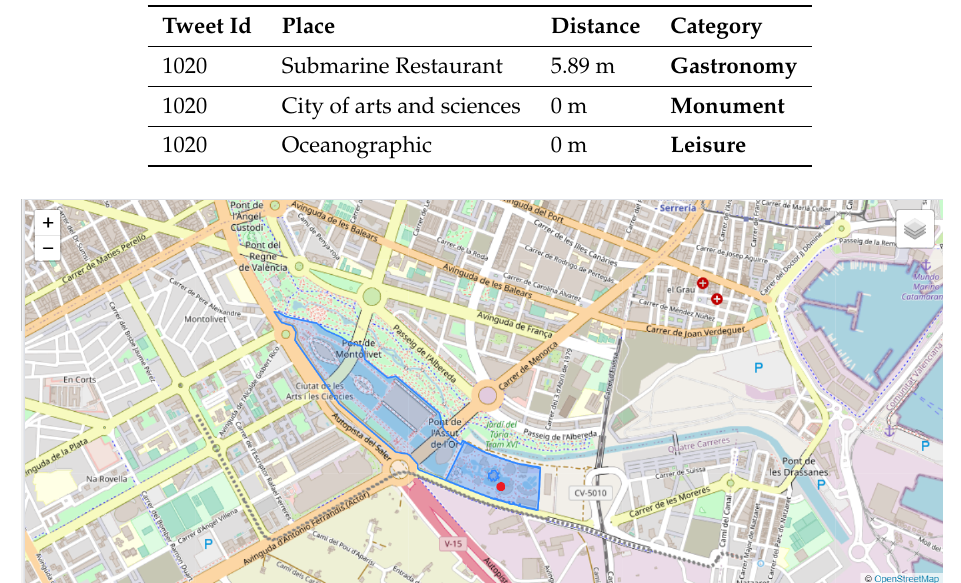
Table 4. Example of a tweet processing.